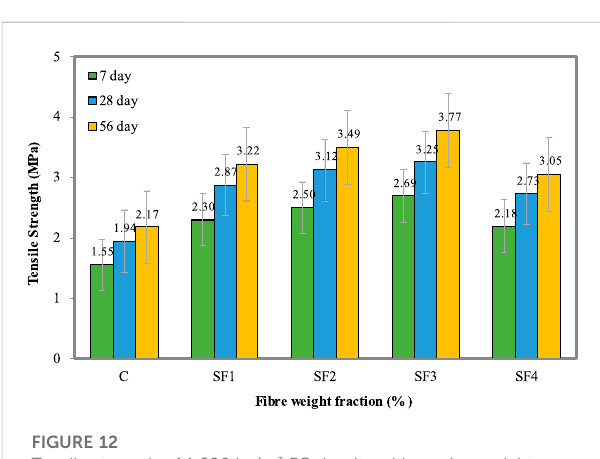
FIGURE 9 Flexural strength of 1,600 kg/m 3 FC density with varying weight fractions of SF.